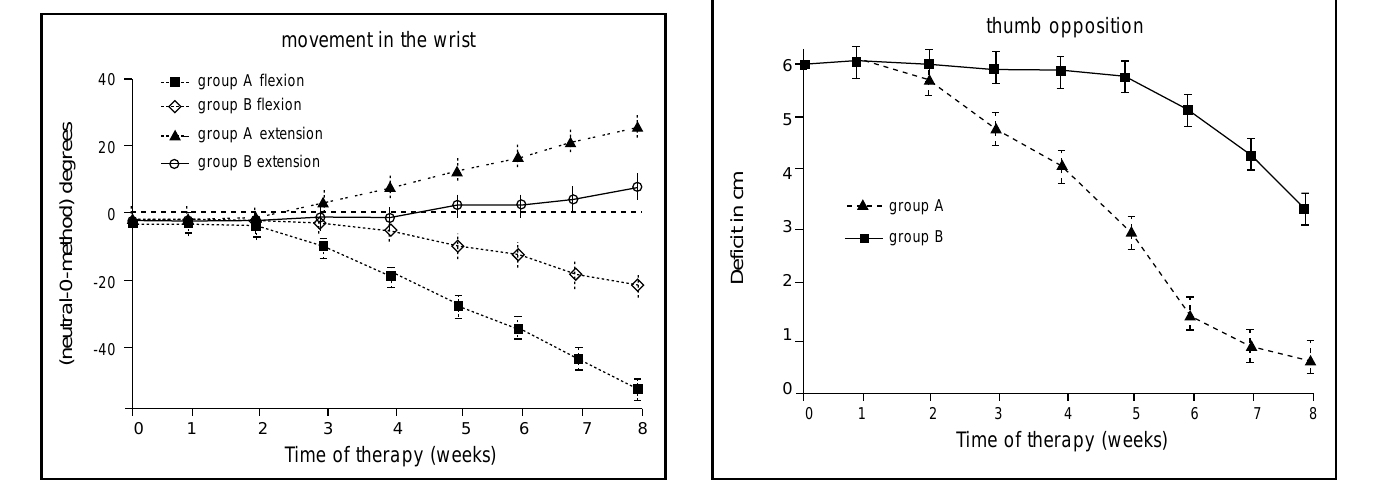
Figure 4: Development of remobilisation of hand contraction in the therapy groups (group A: n=20, group B: n=20)